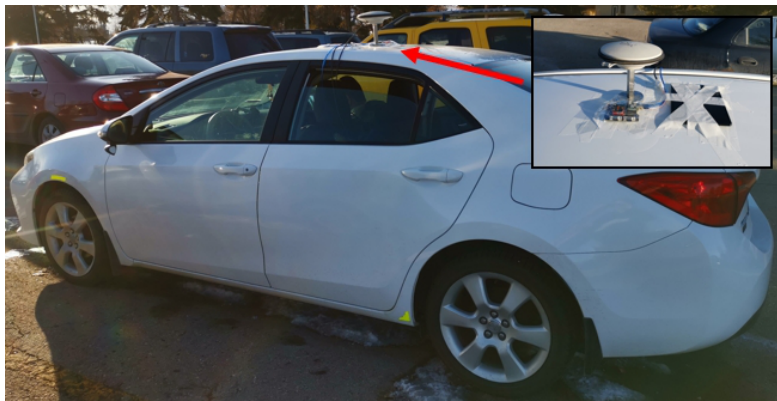
(cid:113) + err 2 + err 2 err 2 . E N U